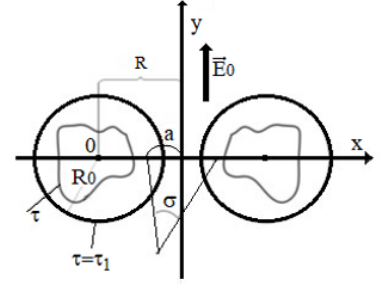
Fig. 2. System of cylinders with a nonconcentric